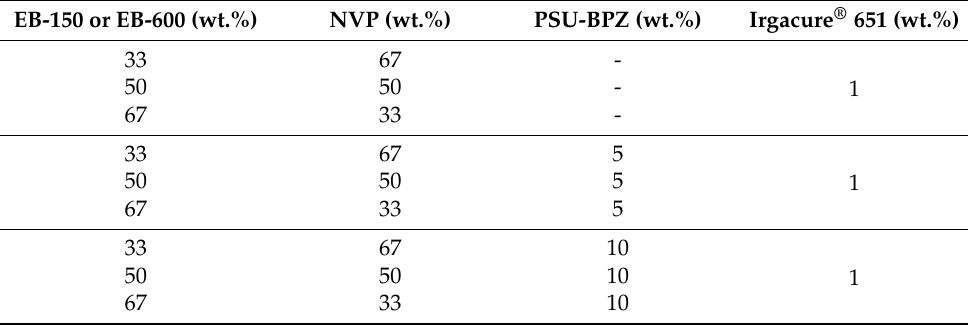
Table 3. Amounts of chemical compounds used for polymerization of bisphenol Z polysulfone. EB-150 or EB-600